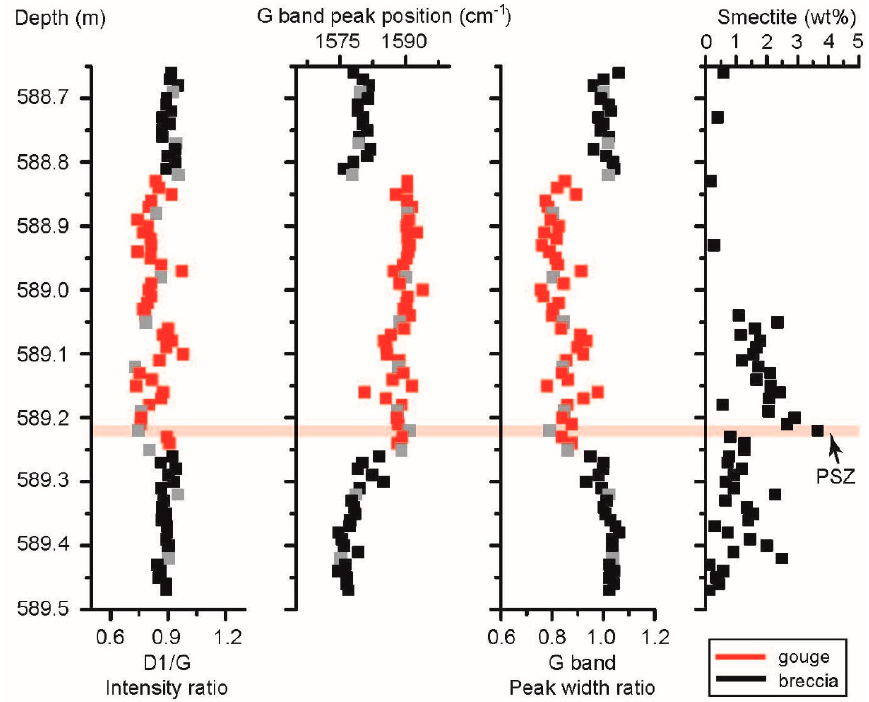
Figure 3. Raman spectra of WFSD-1 samples across the Wenchuan fault zone, including the recognized 2008 Mw 7.9 Wenchun principal slip zone (PSZ). Grey rectangles representing the location of analyzed samples by Kuo et al. [17]. The reported phyllosilicate mineral (the abundance of smectite; [12] Si et al., 2014) is integrated in the right panel, showing the location of the PSZ.